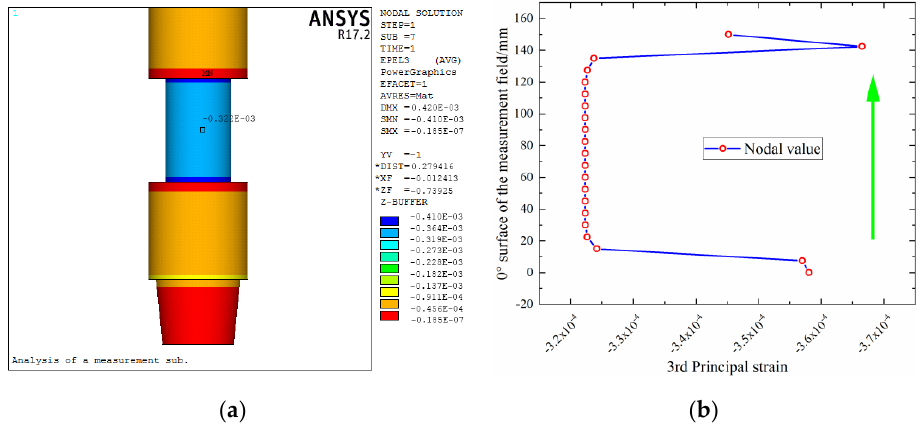
Figure 10. Strain distribution of elastic cell under weight on bit (WOB): ( a ) contour; ( b ) axial distribution.